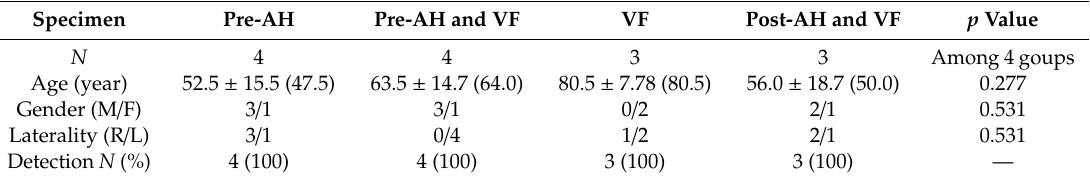
Table 4. Clinical characteristics of ARN patients with VZV infection classified into four groups according to type of ocular fluid